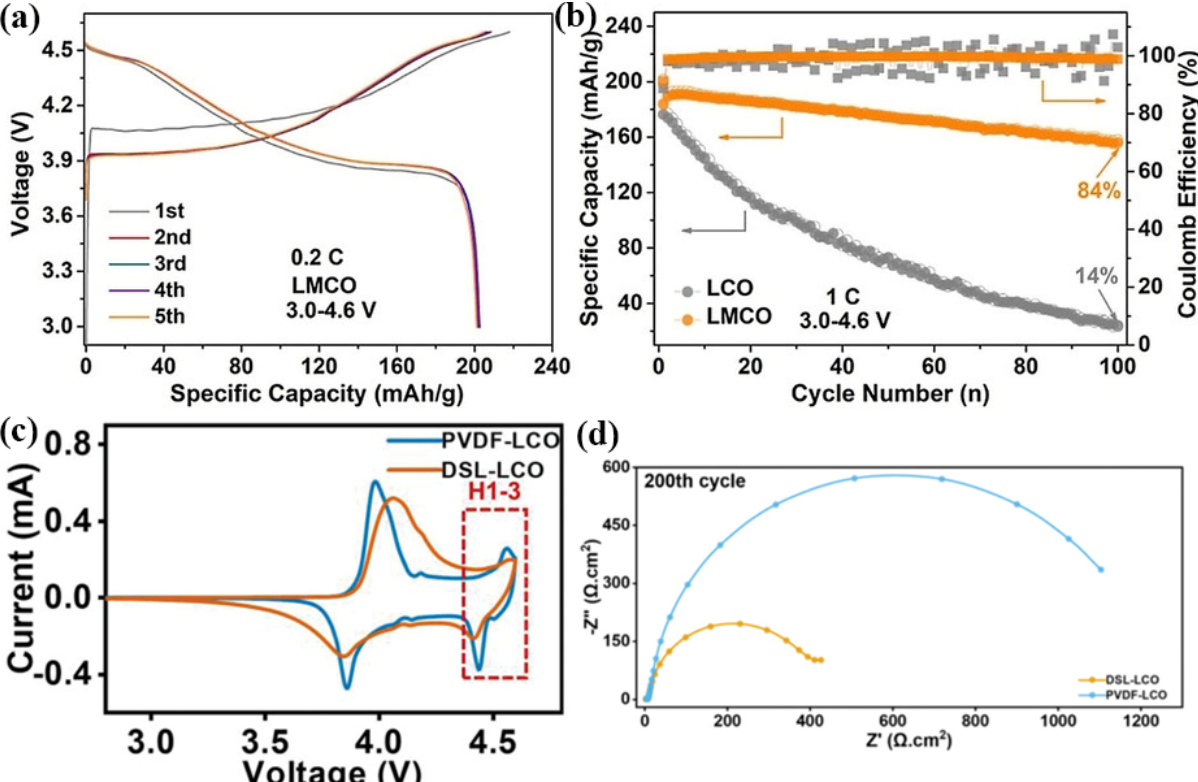
Figure 5. ( a ) Charge/discharge curves and ( b ) cycling performance of Mg-doped LCO electrodes. ( c ) Cyclic voltammetry curves and ( d ) electrochemical impedance spectra of PVDF-LCO and DSL-LCO.